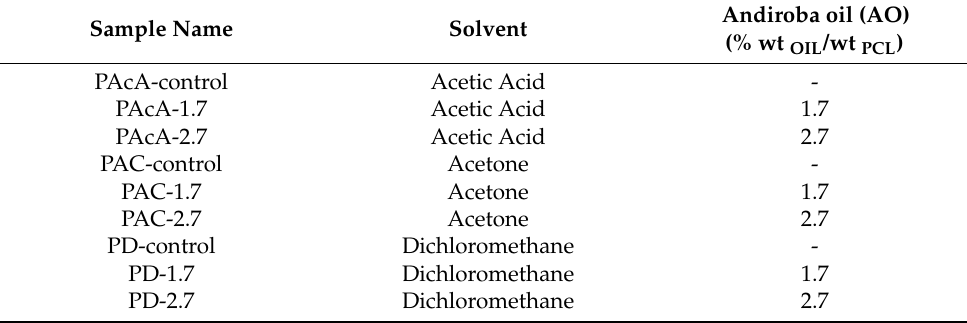
Table 2. Samples identification and composition.